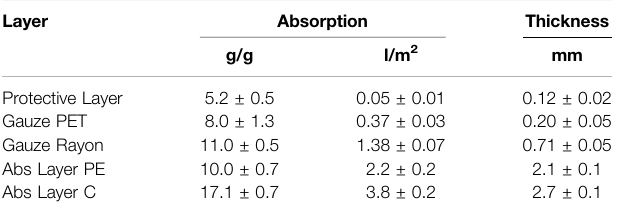
TABLE 2 | Physical properties of the layers investigated. The absorption is reported both in g/g and in l/m 2 to indicate the amount of volume absorbable by the textile material compared to its initial weight or to its planar dimensions,